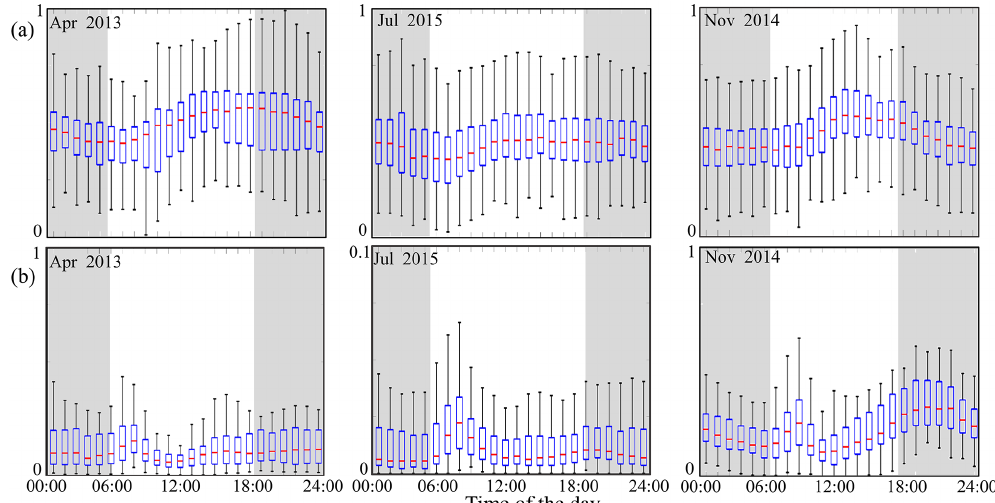
Figure 4. Box-and-whisker plots depicting the 90th, 75th, 50th, 25th, and 10th percentiles for normalized diel variability in O 3 (a) and BC (b) at JSM_STA during April 2013 (pre-monsoon), August 2014 (monsoon), and November 2014 (post-monsoon). Scale for August 2014 is from 0 to